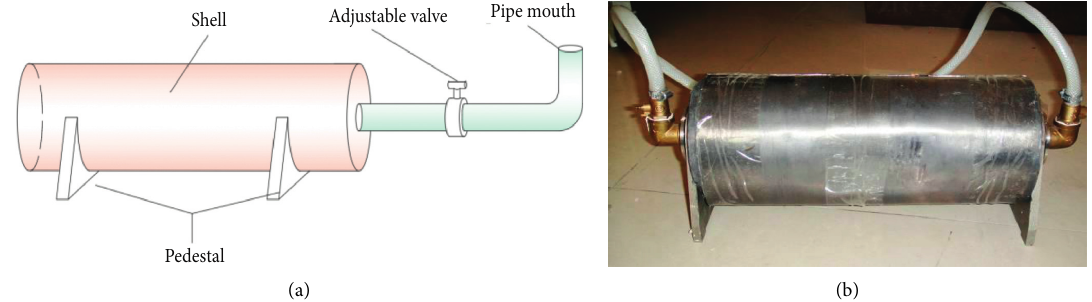
Figure 4: Schematic of the radon output device: (a) structure shape and (b) physical